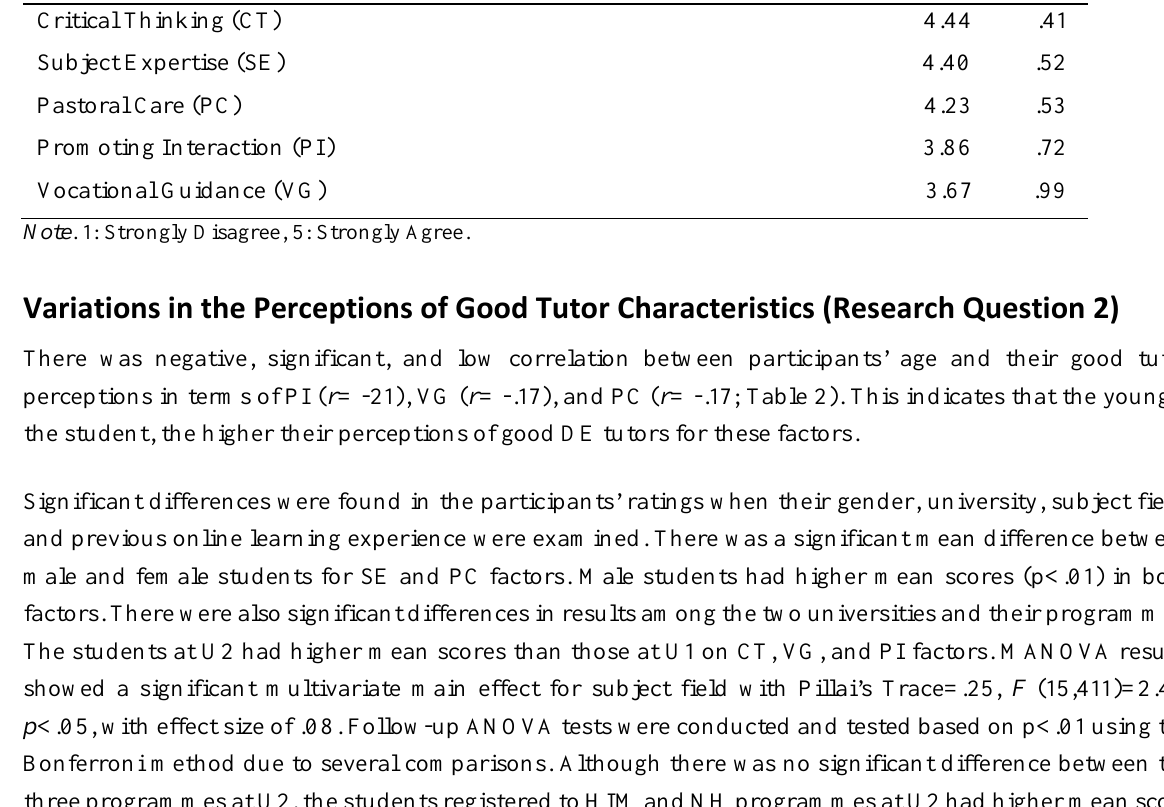
Descriptive Analysis Results of the Factors in the Questionnaire Factors in the